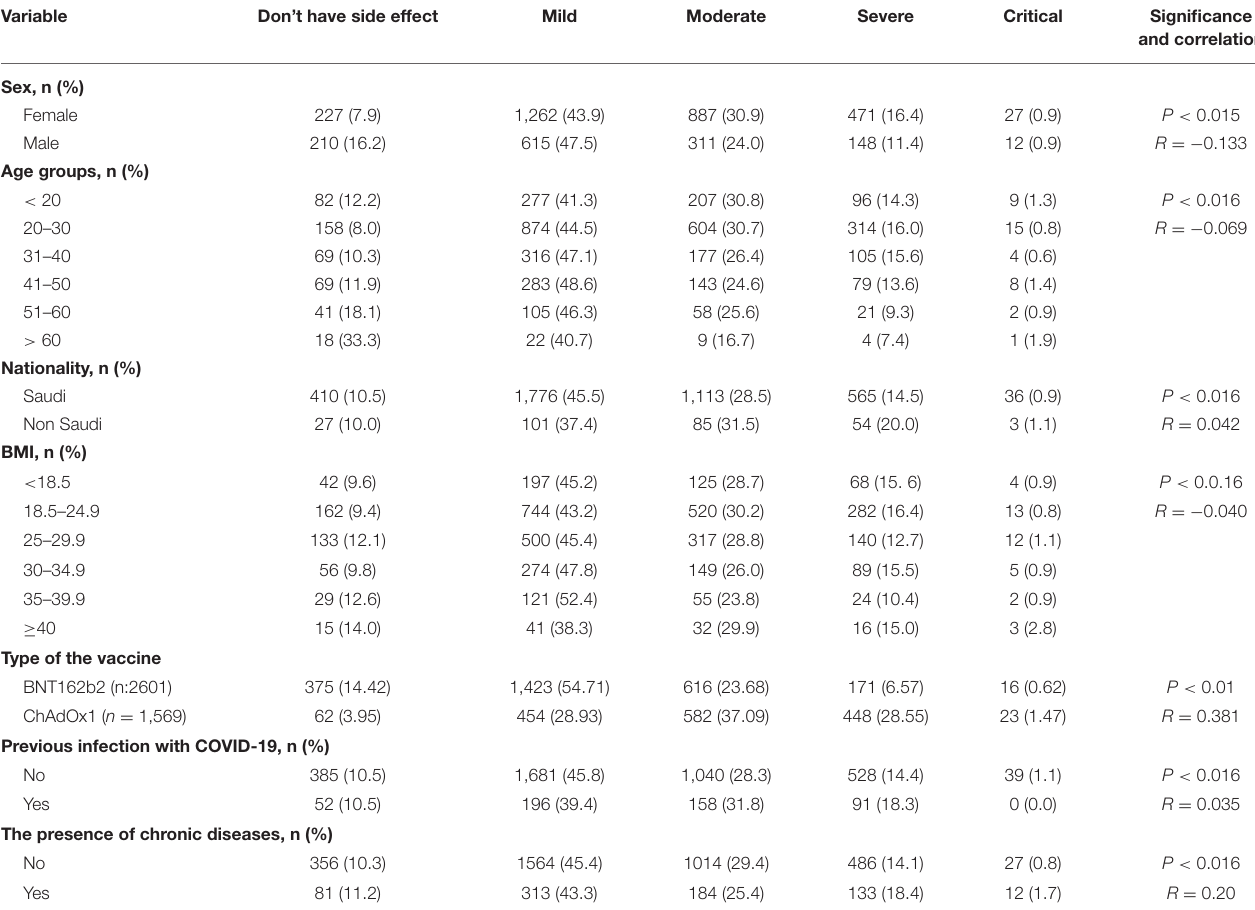
TABLE 2 | Correlation of the severity of the post-vaccinal reactions and different parameters. Variable Critical Significance